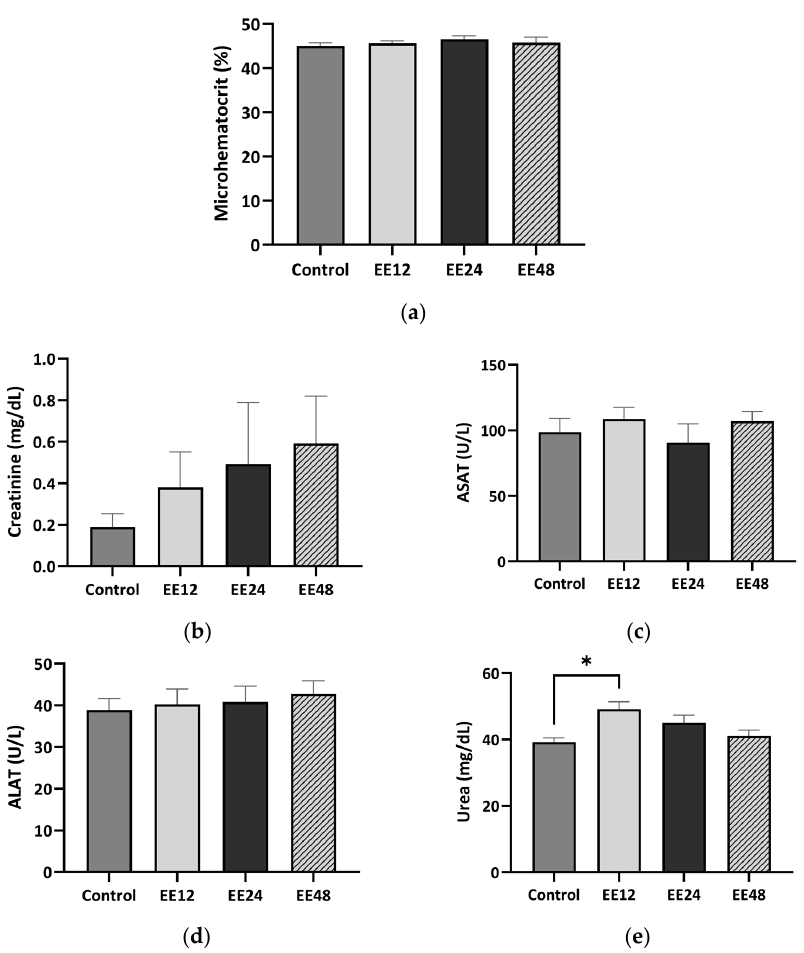
Figure 3. Hematological parameters evaluated (mean ± SE): ( a ) microhematocrit, ( b ) creatinine, ( c ) ASAT (aspartate aminotransferase), ( d ) ALAT (alanine aminotransferase), and ( e ) urea. * Statisti- cally significant differences ( p < 0.05).